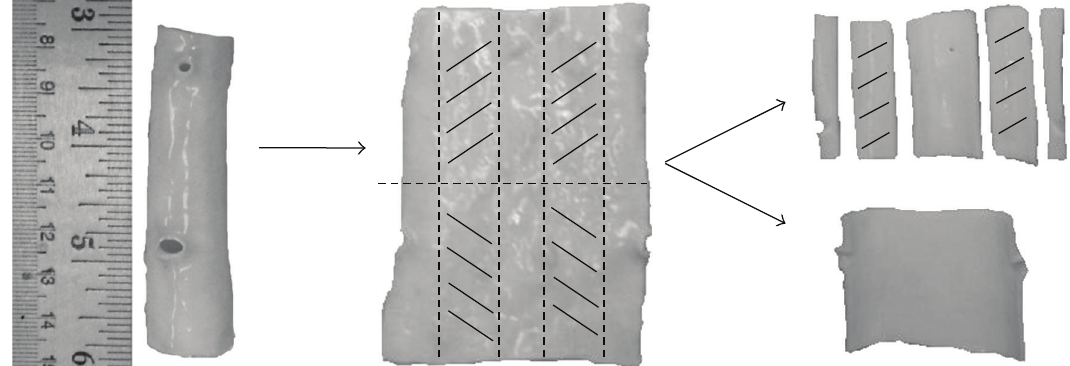
Figure 1: Longitudinal sample preparation: cuts made on dashed lines, similarly cross-hatched sections are paired samples.